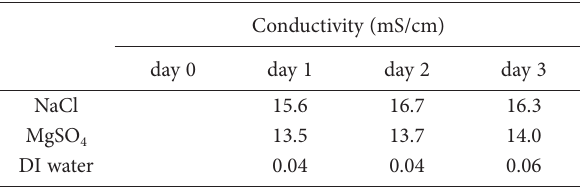
Table 7. Electrical conductivity results for 0.2 M salt solutions (Conductivity in gel) with experimental error ± 0.05